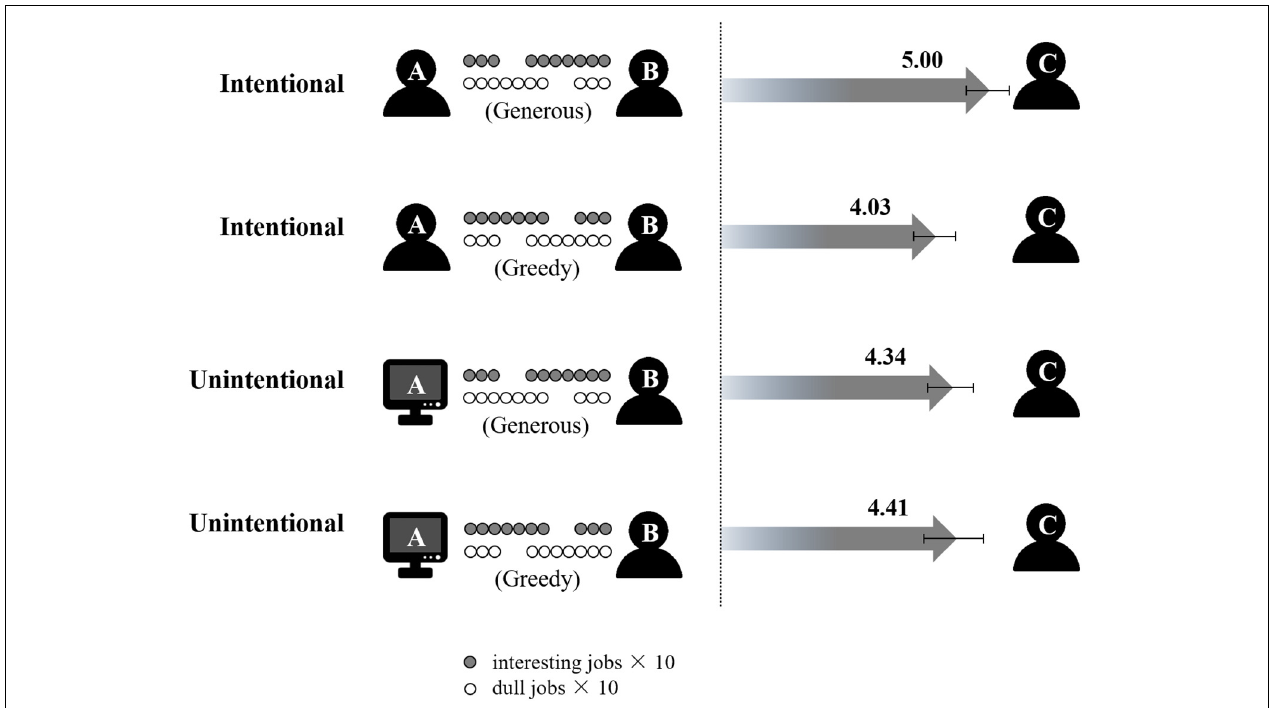
FIGURE 3 | The manipulation of the treatment in the first round of dictator game and the results in Experiment 2. The number above gray arrow is the average number of interesting jobs for player C among all 10 interesting jobs, and the error bar represents one S.D. The solid circle represents one interesting job, and the hollow circle represents one dull